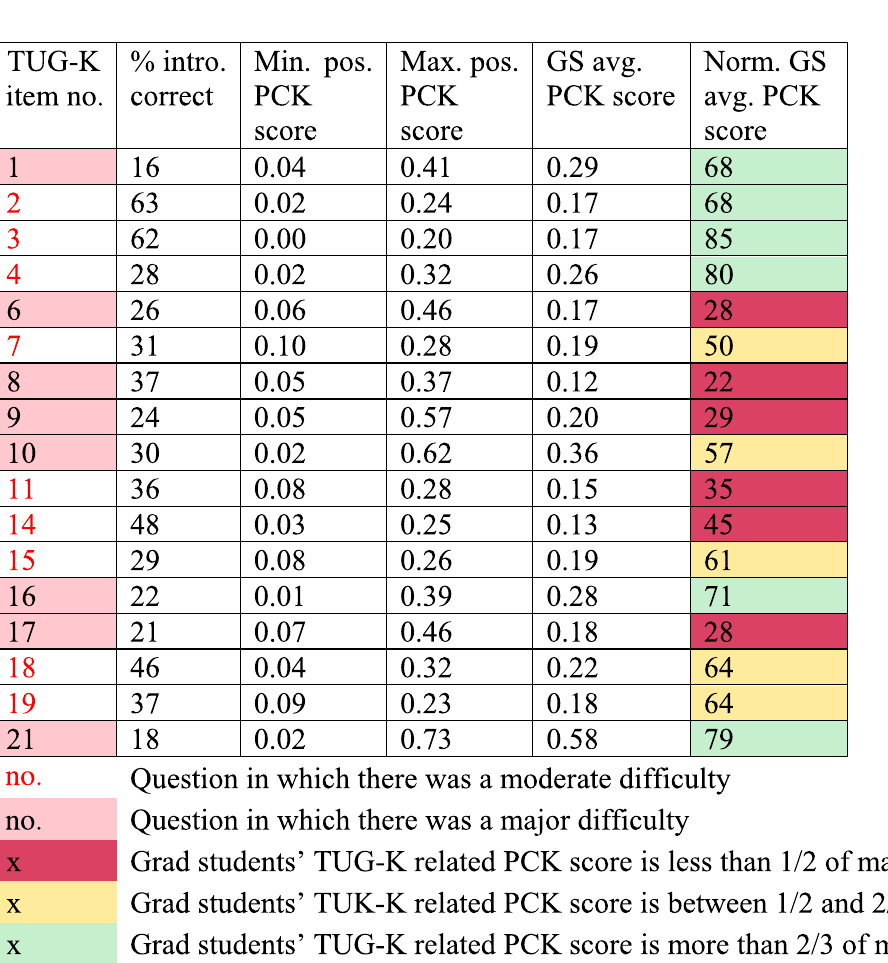
FIG. 2 (color online). Questions on the TUG-K on which at least 20% of introductory students selected one incorrect answer choice after instruction, percentages of introductory students who answered each question correctly (% intro. correct), minimum possible TUG-K related PCK score (Min. pos. PCK score), maximum possible TUG-K related PCK score (Max. pos. PCK score), graduate students’ average PCK score (GS avg. PCK score), graduate students’ normalized average PCK score on a scale from 0 to 100 (Norm. GS avg. PCK